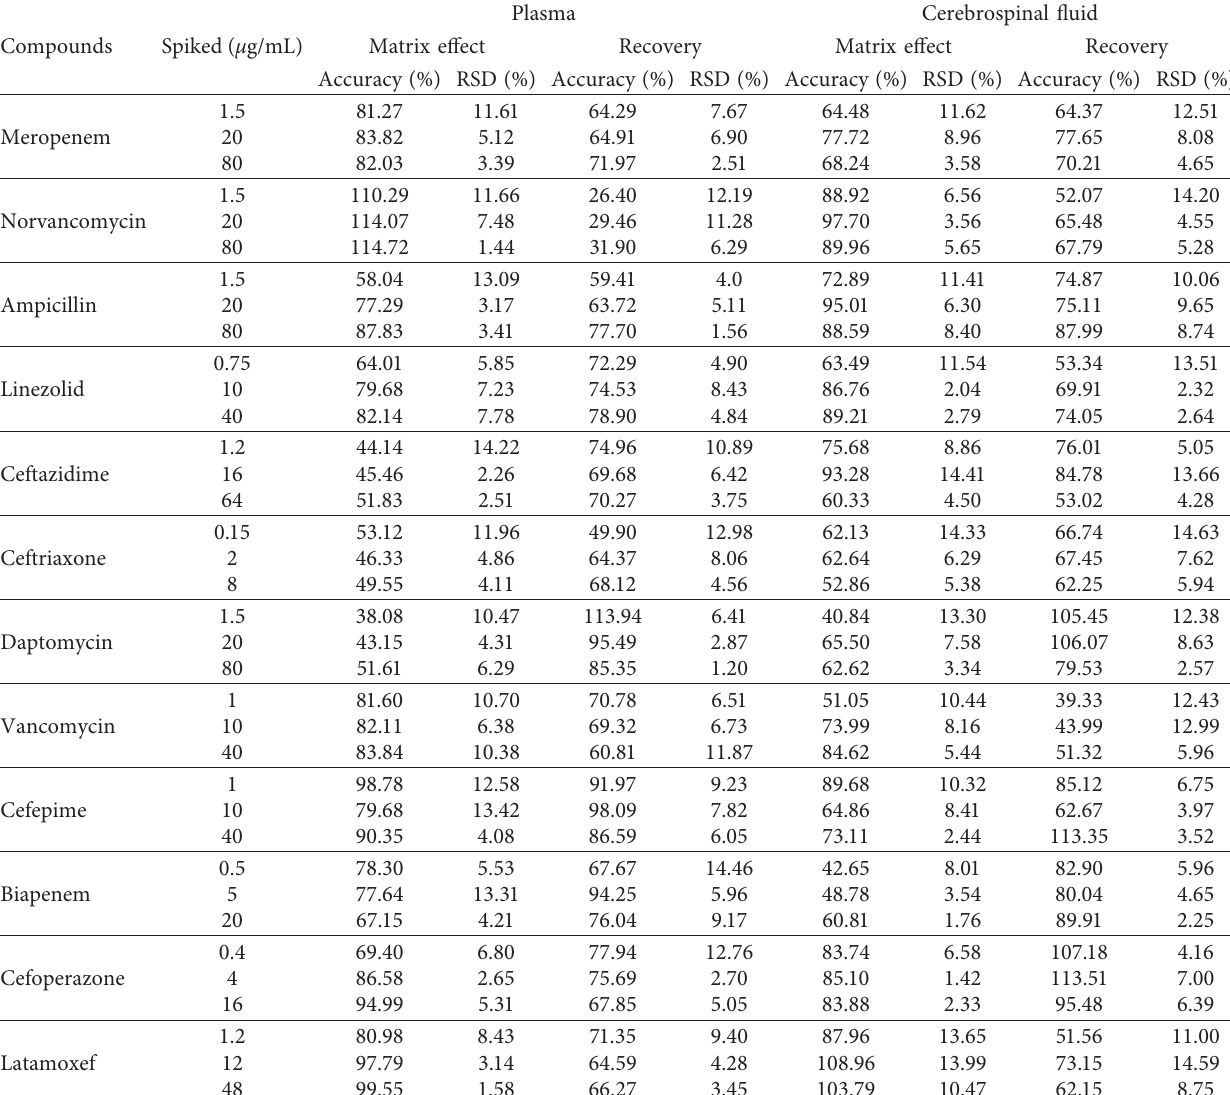
Table 4: Matrix effects and recoveries of 14 antibiotics in plasma and cerebrospinal fluid ( n � 6). Plasma Cerebrospinal fluid Matrix Compounds Spiked ( μ g/mL)